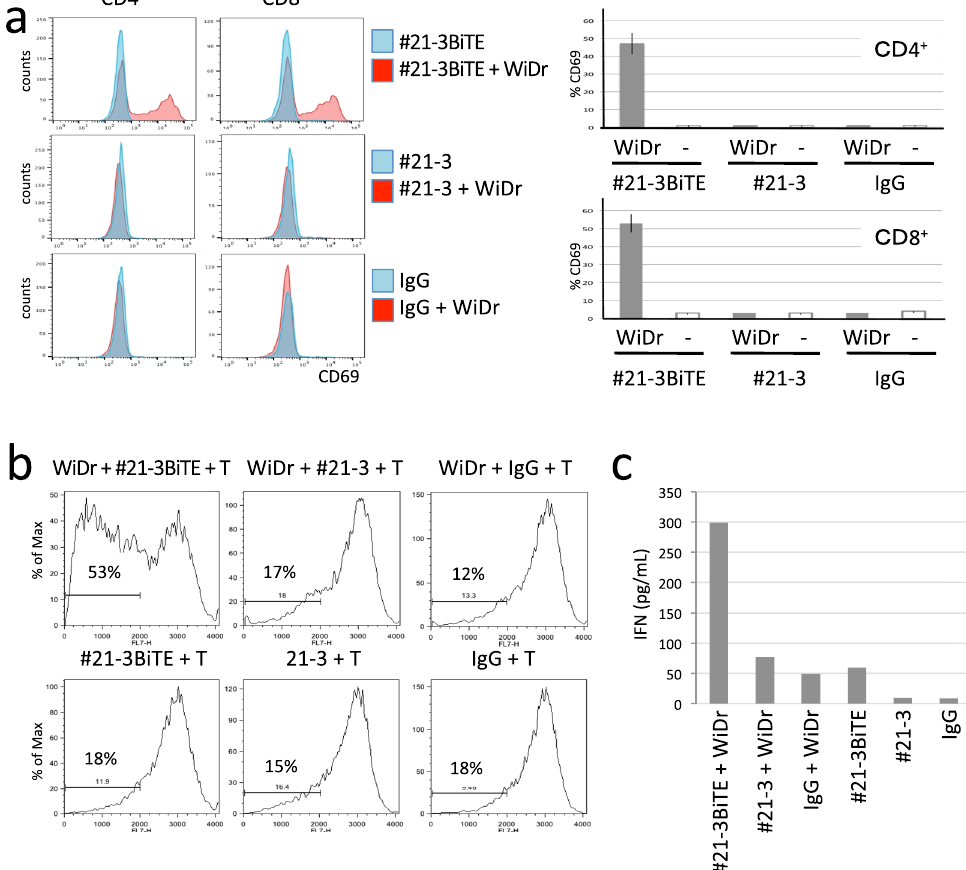
Figure 4. #21-3BiTE mediates T-cell activation and proliferation. ( a ) #21-3BiTE activates naïve T-cells by bridging T cells and target cells. PBMC from HLA-A * 24 + healthy donor were mixed with or without WiDr cells at an E:T ratio of 10:1 in the presence of #21-3BiTE, 21-3 or control mouse IgG, and the reactions were allowed to proceed for 48 h. Cells were labeled with fluorescently coupled antibodies to CD4, CD8, and CD69 and were analyzed by FACS. Each FACS histogram shows CD69 binding. Representative FACS histograms (left) and frequency of CD69-positive cells in CD4 + or CD8 + cells are shown (Right). Data are representative of two independent experiments (n = 3). ( b ) T cells expanded from a HLA-A * 24 + healthy donor were labeled with CellTrace-Blue. Labeled T-cells were mixed with or without WiDr cells at an E:T ratio of 10:1 in the presence of the indicated antibody, and the reactions were allowed to proceed for four days. CellTrace-Blue + cells analyzed by FACS for proliferation are shown. Representative data from two independent experiments are shown. ( c ) Cell culture supernatants in ( b ) were analyzed for IFN γ by ELISA. Values are represented by the means of two independent experiments for two